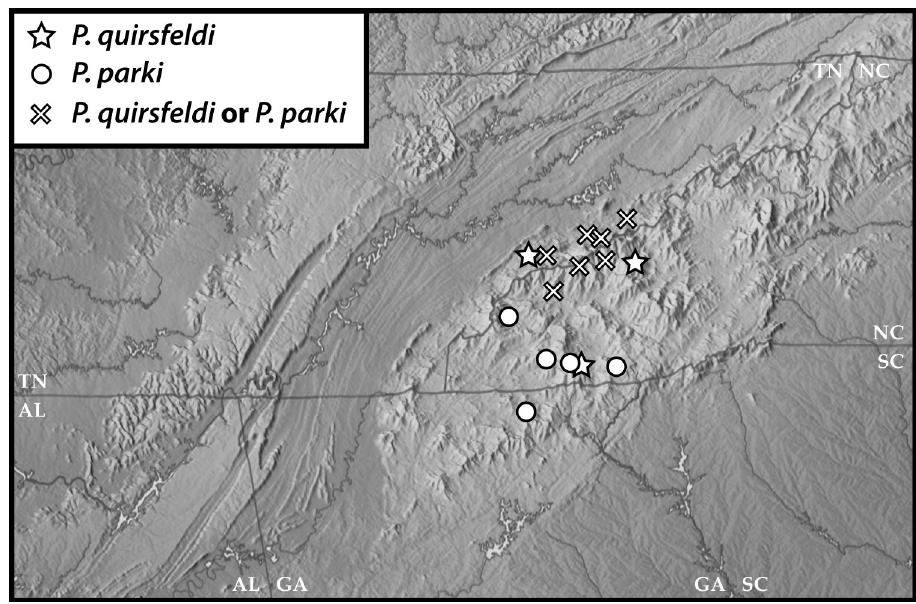
Figure 48. Map of southern Appalachia with specimen records for P. quirsfeldi , P. parki , and for a num- ber of specimens which we cannot positively identify as one or the